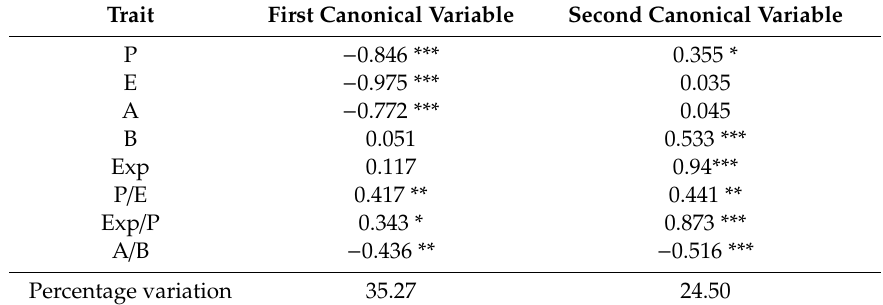
Table 4. Correlation coefficients between the first two canonical variables and original traits. Trait